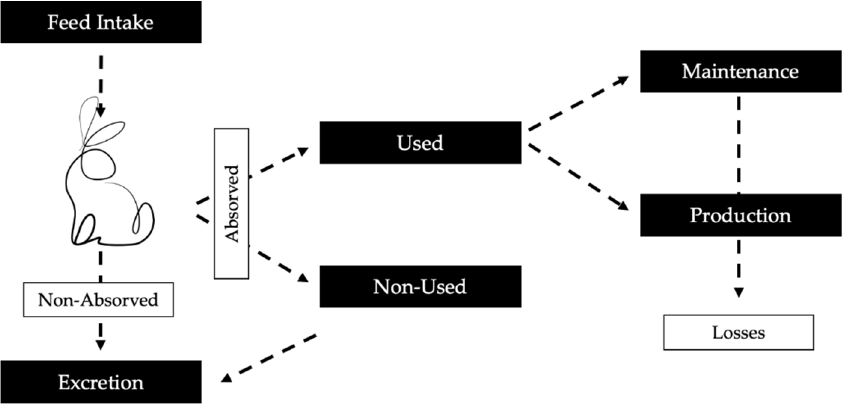
Figure 1. Nutritional distribution within an animal.